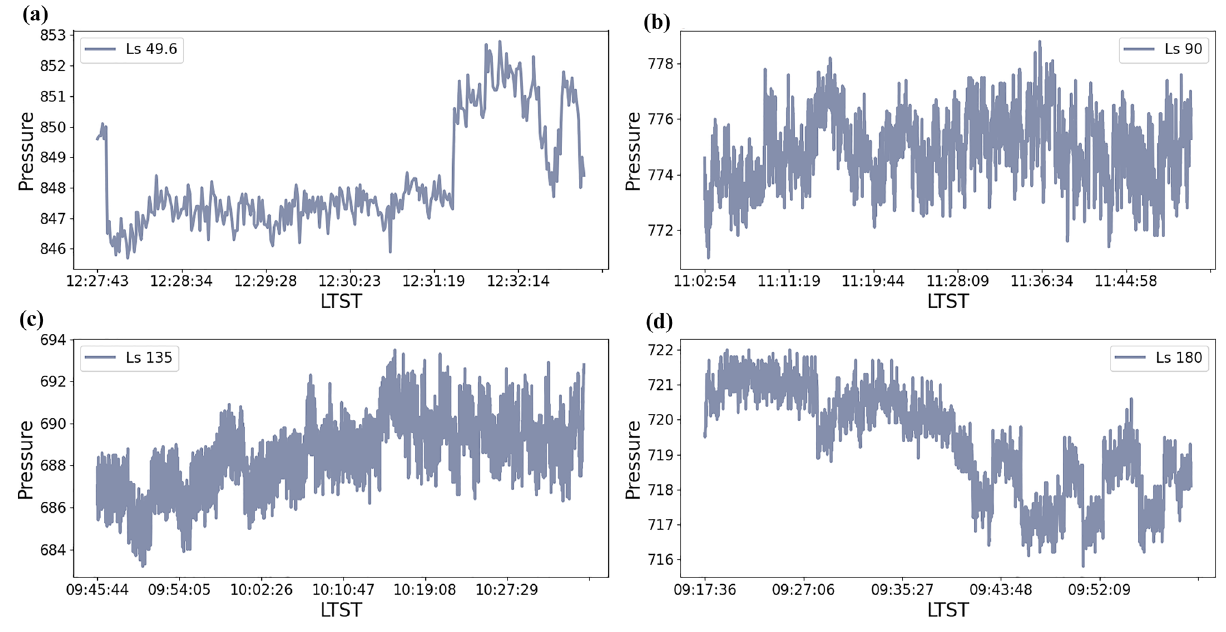
Figure 4. The pressure bumps occur in one sol at different Ls. For ( a ), where Ls = 49.6°, since the Zhurong rover just landed on the surface of Mars, it works with a traditional mode in order to acclimate to the Martian environment and test the sensors capabilities. For that, only 5-min information is recorded. For ( b – d ), the rover works with a maneuver mode and the pressures are recorded about 40